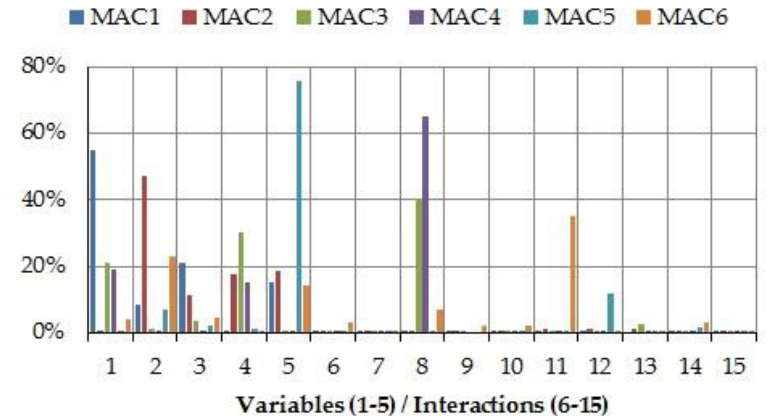
Figure 8. Percentage contribution for MAC values in design number 4: 1–5, design variables k X 210 , k Y 3 , k Z 4 , k X 8 , and k Y 9 , respectively; 6–15, two factor interactions k X 210 – k Y 3 , k X 210 – k Z 4 , k X 210 – k X 8 , k X 210 – k Y 9 , k Y 3 – k Z 4 , k Y 3 – k X 8 , k Y 3 – k Y 9 , k Z 4 – k X 8 , k Z 4 – k Y 9 , and k X 8 – k Y 9 , respectively.